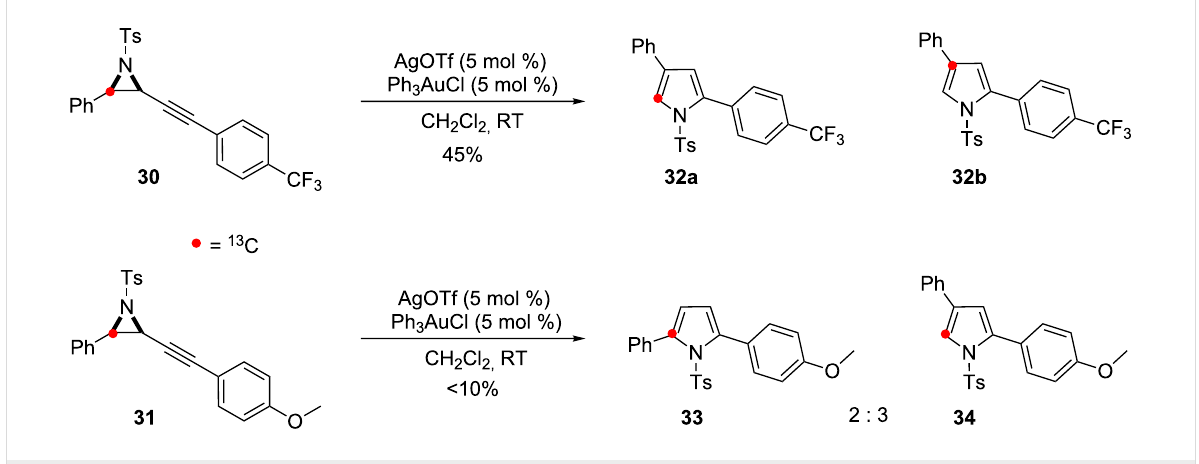
Scheme 13: Electronic effects on the outcome of the skeletal rearrangement processes.